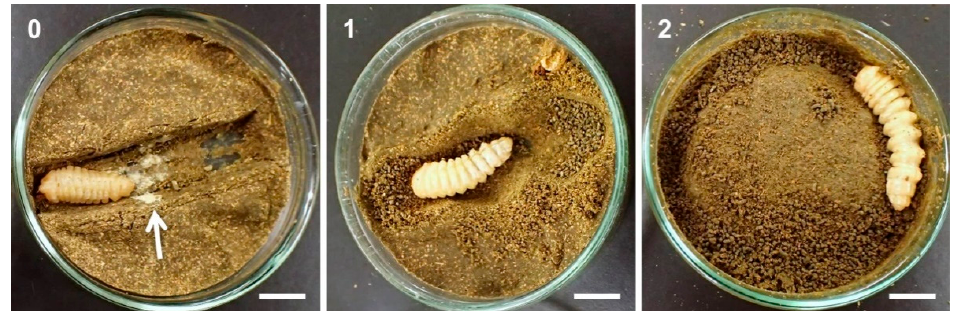
Figure 1. Diet excavation by Aromia bungii late instar larvae. Excavation score: 0 = no trace of excavation, 1 = moderate excavation (central dent not fully filled), and 2 = vigorous excavation (central dent fully filled and tunnel extending to other parts). The arrow in score 0 image shows abnormal white, muddy excretion by the larva, while a lot of normal granular feces can be found in the score 1 and 2 images. Scale bars = 1 cm.